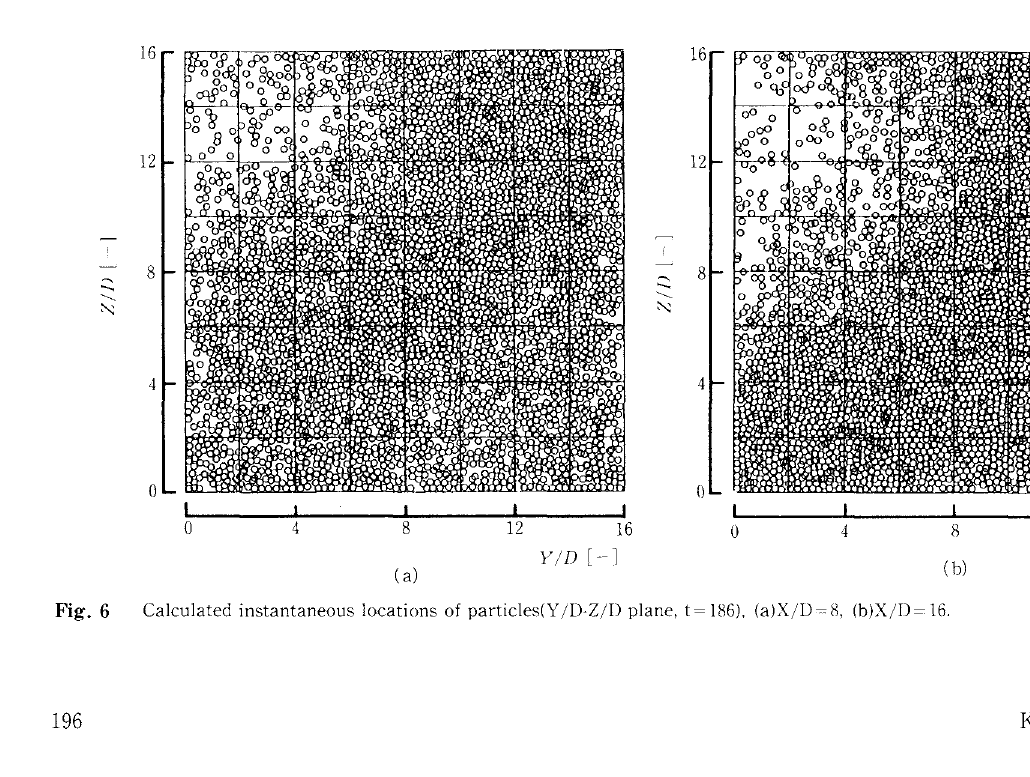
Fig. 6 Calculated instantaneous locations of particles(Y /D-Z/D plane, t= 186). (a)X/D=8. (b)X/D=